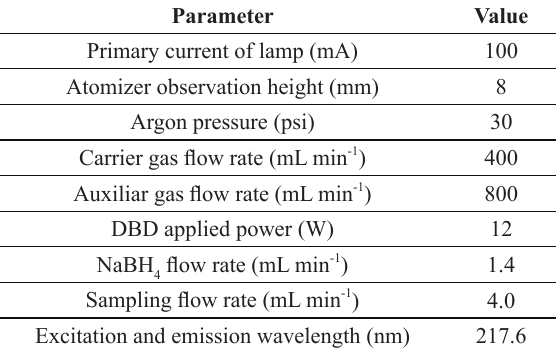
Operational parameters of HG-AFS for antimony